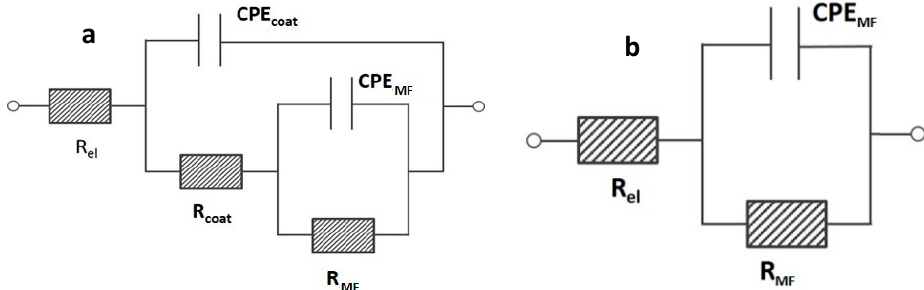
Figure 8. Electrical equivalent circuits employed to fit the experimental spectra ( a ) of samples PSZ-20, PSZ-30, PSZ-40 and ( b ) of samples PSZ-10 and the bare steel.